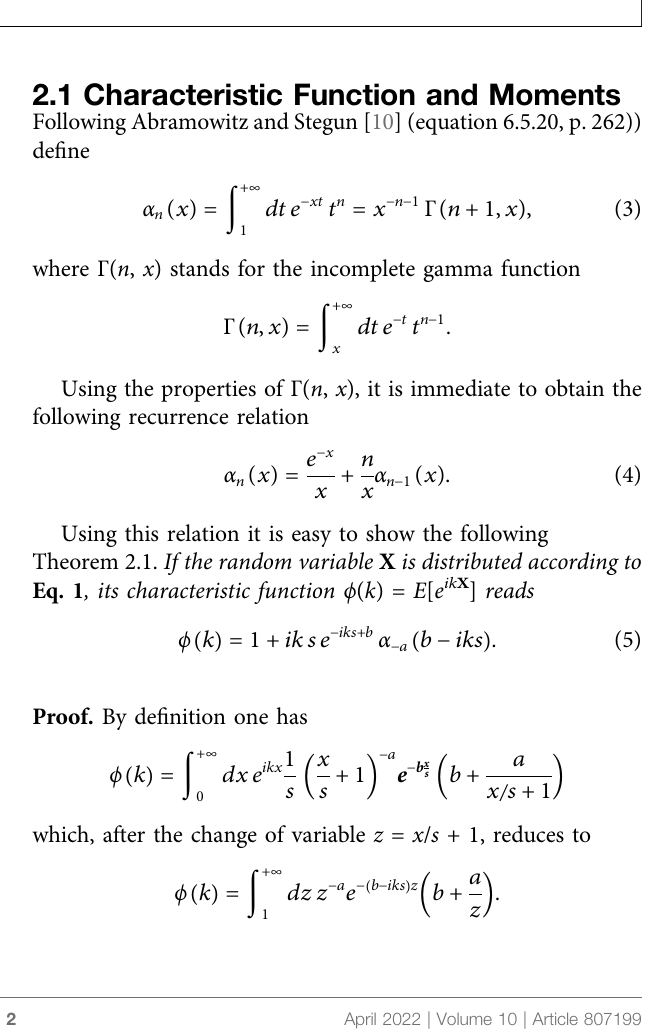
FIGURE 1 | Lower (left) and upper (right) tail of the survival function of the Pareto III distribution for a = 1, s = 1 and different values of the exponential coef fi cient b . The case b = 0 corresponds to the Zipf ’ s law log(1 − F ( x )) ~ x − 1 .